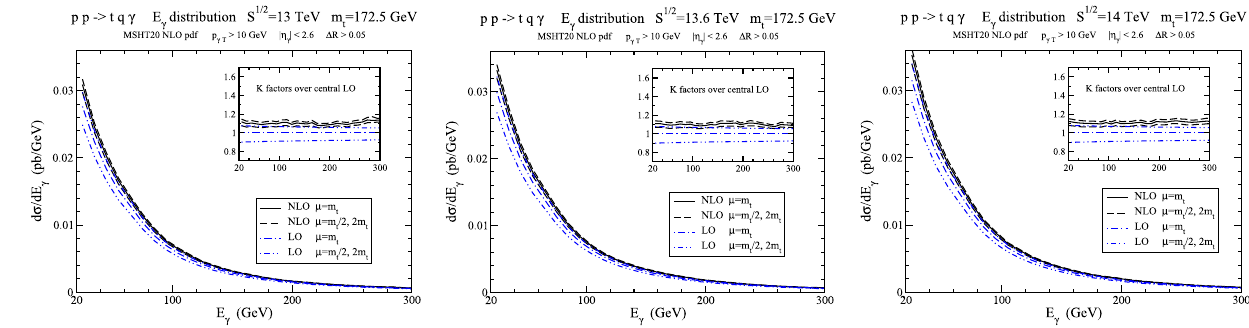
Fig. 6 The LO and NLO photon energy distributions in tq γ production at (left) 13 TeV, (middle) 13.6 TeV, and (right) 14 TeV LHC